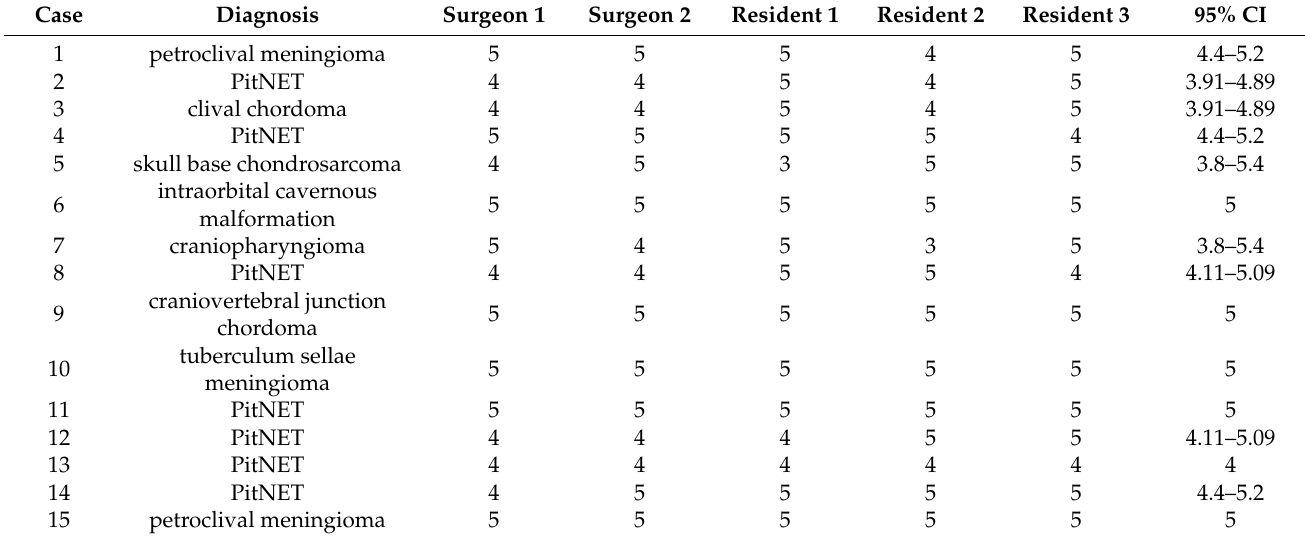
Table 3. Results of assessment of AR navigation.